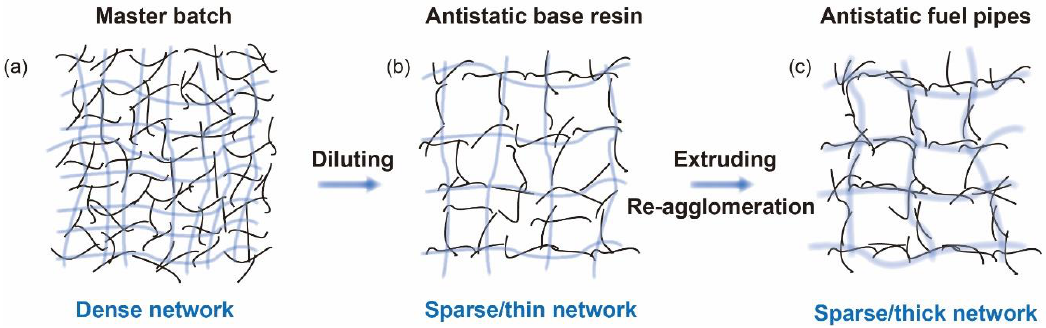
Figure 7. The mechanism of antistatic properties for PA1012 fuel pipes. The image depicted the conductive network of ( a ) master batch, ( b ) antistatic base resin and ( c ) antistatic fuel pipes. (Here the black lines represented the MWCNTs, and the gray blue lines represented the conductive network.).